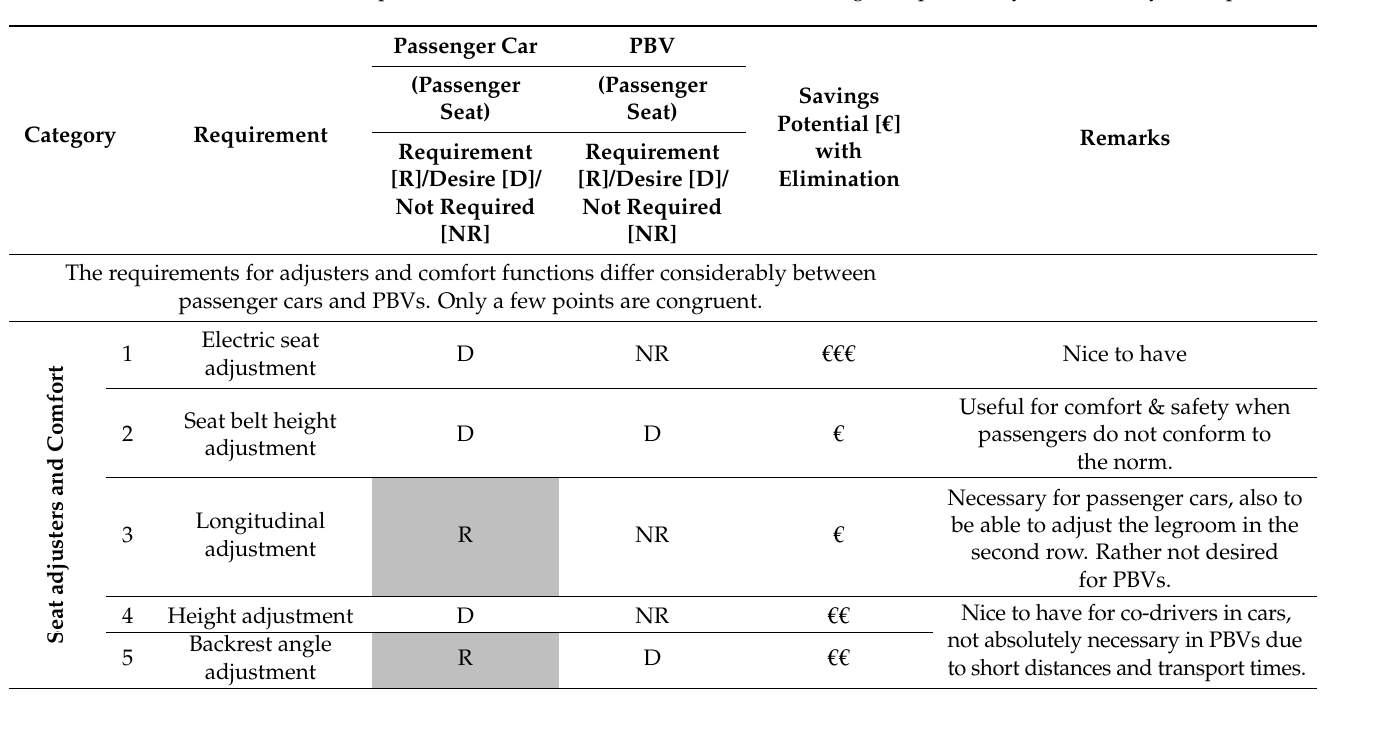
Table 3. Potential analysis in seat development for PBVs compared to existing seat concepts. For